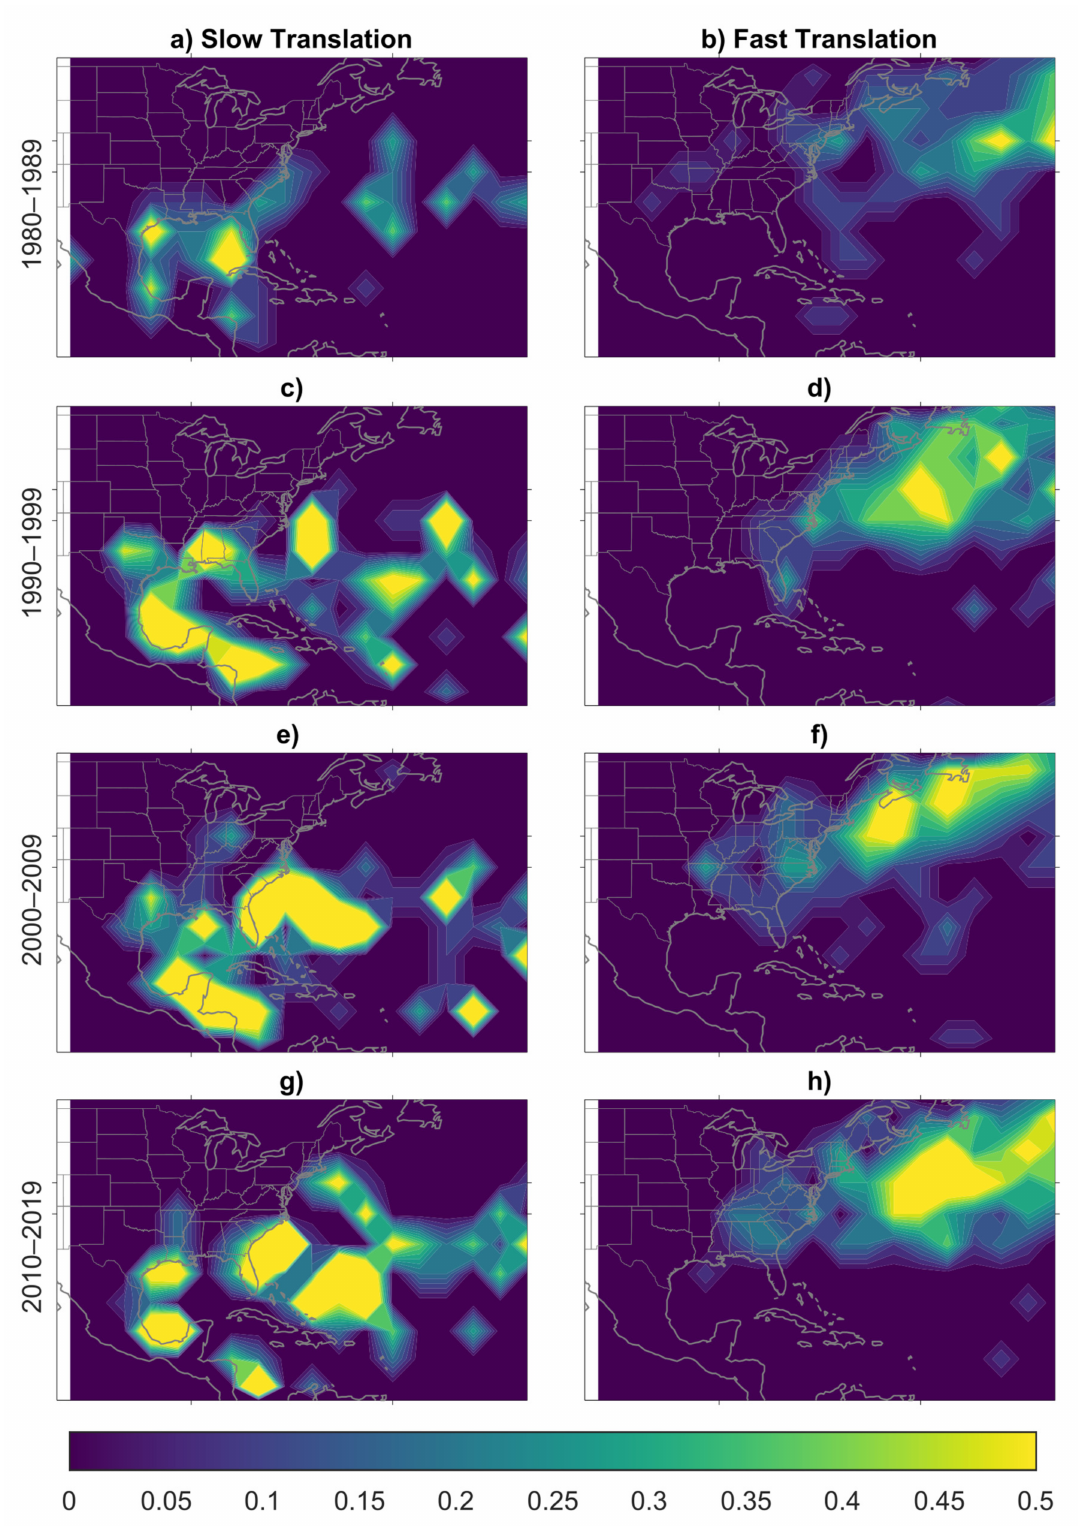
Figure 2. Annual mean density (shading; unit: events) of slow and fast tropical cyclone extreme transla-tion events in the North Atlantic averaged over during ( a , b ) 1980–1989, ( c , d ) 1990–1999, ( e , f ) 2000–2009 and ( g , h )